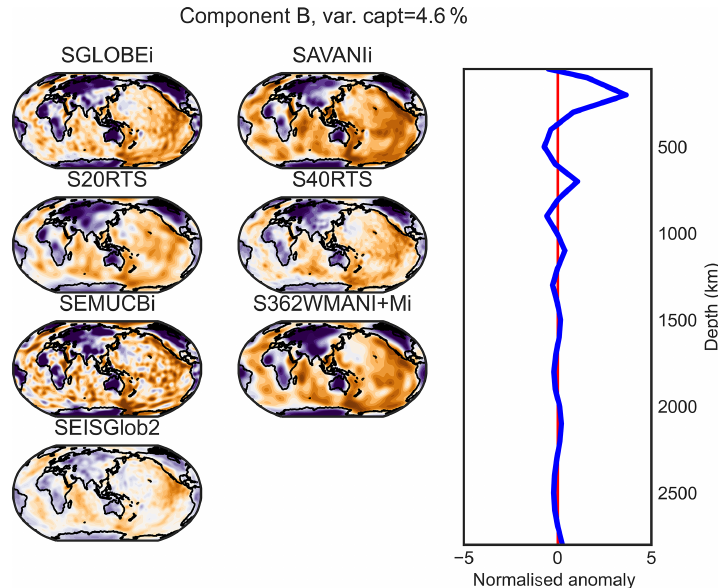
Figure D2. PC B (maximum at 200km of depth) of the combined analysis of the isotropic parts of the